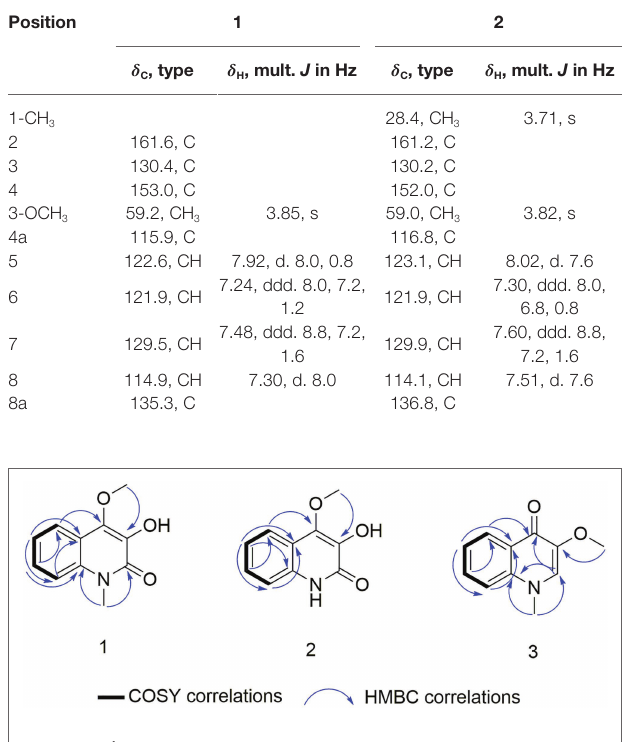
FIGURE 6 | COSY and key heteronuclear multiple bond correlation (HMBC) correlations for 1–3.